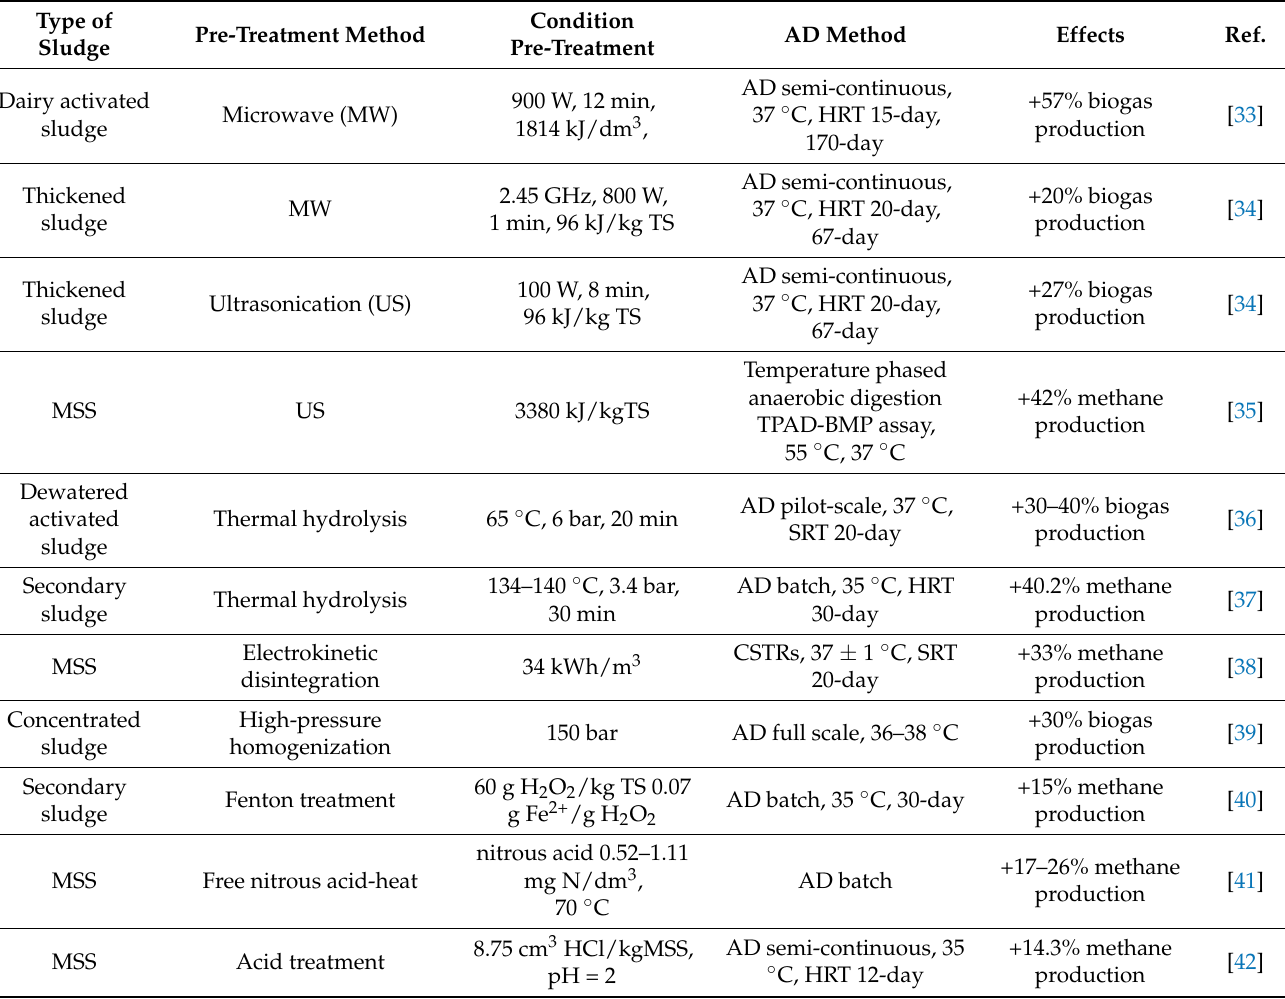
Table 2. Example effects of various methods of pre-treatment of sewage sludge before